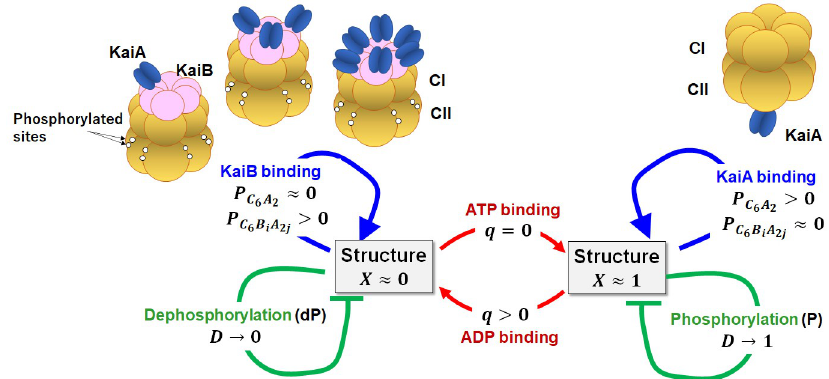
Fig 1. Feedback coupling among reactions and structural transitions in KaiC hexamer. The model is based on the fundamental experimental observations: KaiC forms a hexamer composed of the CI and CII rings. The CII has twelve sites to be phosphorylated. The KaiC hexamer undergoes allosteric transitions between two structures; the structure ( X � 1) in the phosphorylation (P) phase and the structure ( X � 0) in the dephosphorylation (dP) phase. A KaiA dimer can bind on the CII of the X � 1 KaiC with the probability P , which promotes the P process to increase the C 6 A 2 phosphorylation level D . KaiB monomers can bind on the CI of the X � 0 KaiC, and a KaiA dimer can further bind on each KaiB monomer forming KaiC-KaiB-KaiA complexes with the probability P describes the feedback coupling in the KaiC hexamer by assuming ( i ) the KaiA binding on the CII stabilizes the X � 1 state, and ( ii ) the KaiB binding on the CI stabilizes the X � 0 structure. The assumptions ( i ) and ( ii ) account for the positive feedback to stabilize the X � 1 and X � 0 states. The model also assumes that ( iii ) the gradual rise of D destabilizes the X � 1 structure and ( iv ) the gradual fall of D destabilizes the X � 0 structure. The assumptions (iii ) and ( iv ) support the time-delayed negative feedback to drive the transitions between the X � 1 and X � 0 states. The model further assumes ( v ) the stochastic ATP hydrolysis in the CI ( q ! 1) destabilizes the X � 1 state, and ( vi ) the stochastic ADP release from the CI and the subsequent ATP binding ( q ! 0) destabilize the X � 0 state. ( v ) and ( vi ) trigger the transitions between the X � 1 and X � 0 states. The assumptions ( i ) through ( vi ) generate the oscillations of individual KaiC hexamers. We hypothesized ( vii ) oscillations of multiple KaiC hexamers are coupled through the KaiA sequestration into the KaiC-KaiB-KaiA complexes, giving rise to the ensemble-level oscillations.